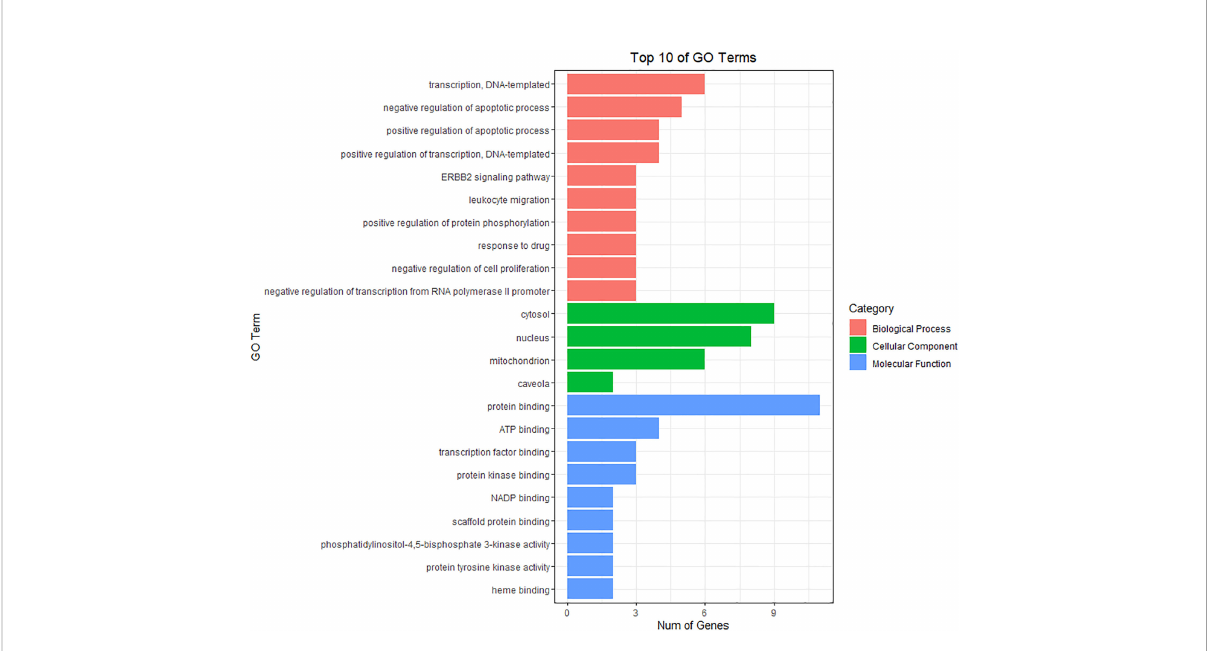
FIGURE 5 GO enrichment analysis for 12 CKI anti-BC